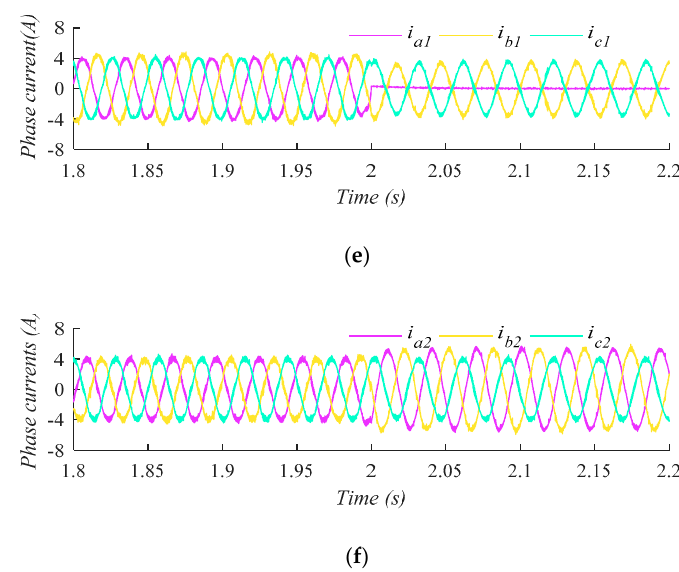
Figure 5. Test 2. Post-fault response when operation point cannot be achievable. From top to bottom: ( a ) motor speed, ( b ) 𝑑 - 𝑞 currents, ( c ) maximum 𝑞 and 𝑞 reference current, ( d ) 𝑥 - 𝑦 currents, ( e ) set 1 of phase currents and ( f ) set 2 of phase currents.